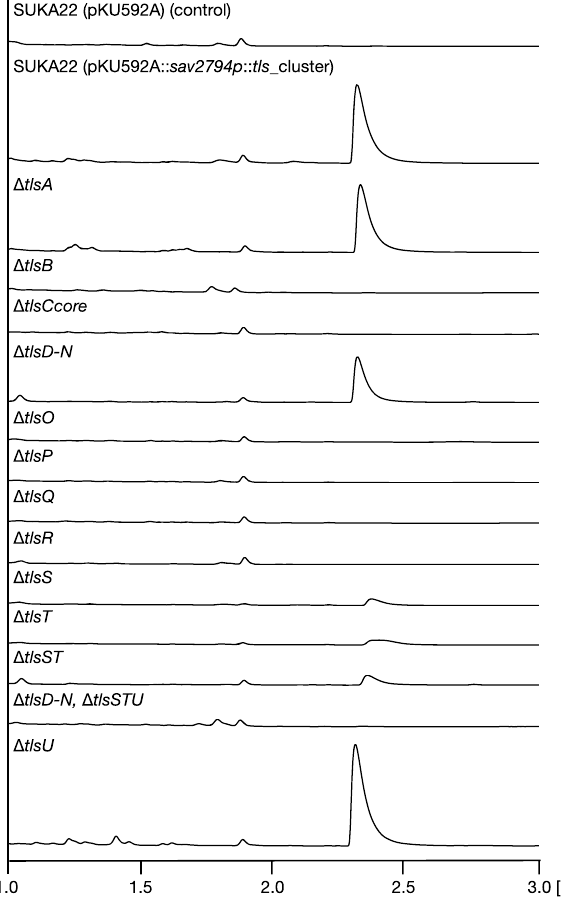
Figure 3. HPLC/MS analysis of metabolites produced by the SUKA22 strain, which was transformed with tls gene cluster containing each indicated tls gene